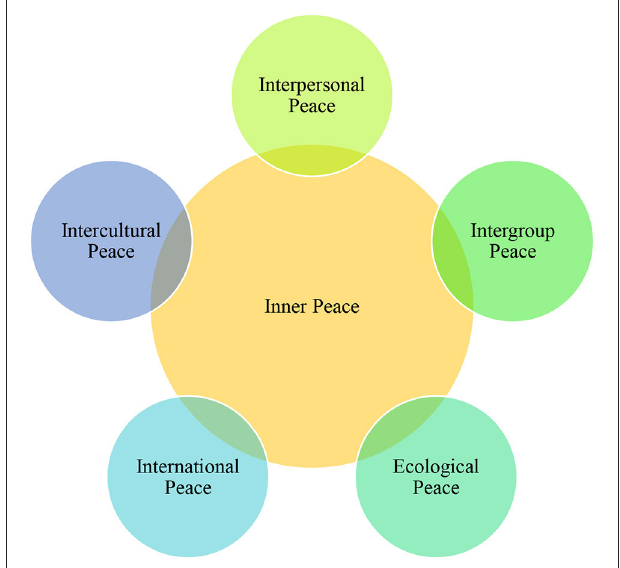
FIGURE 1 | Dimensions of peace